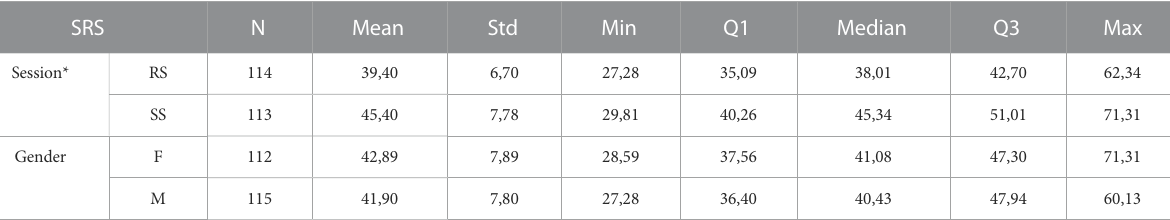
TABLE 8 Stress Reference Scale